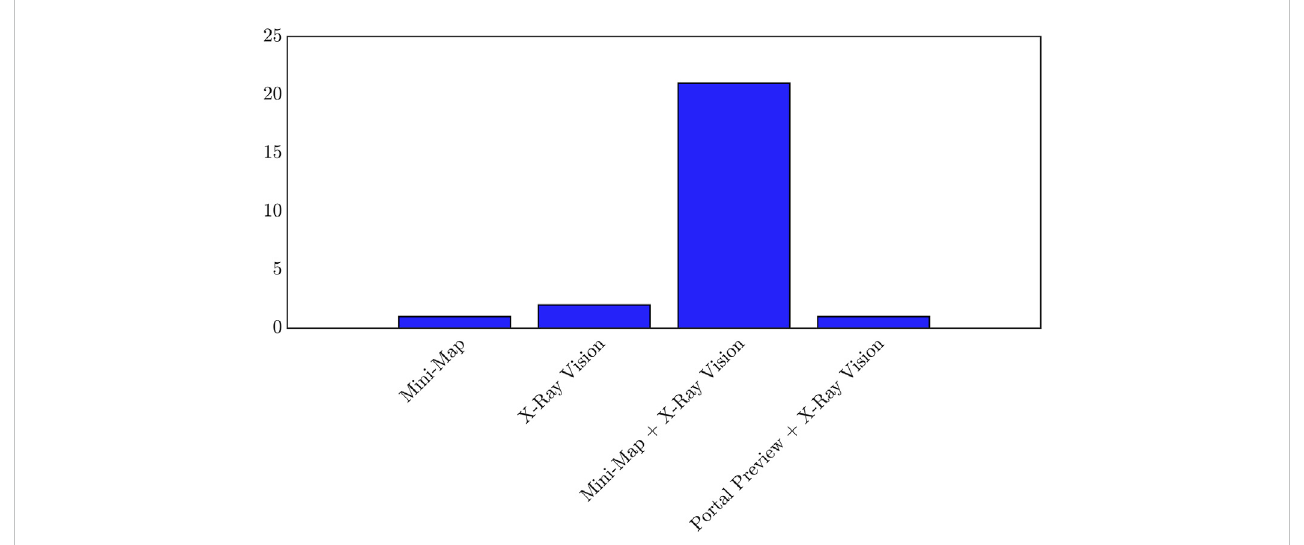
FIGURE 10 Participant ’ s preference for combining individual